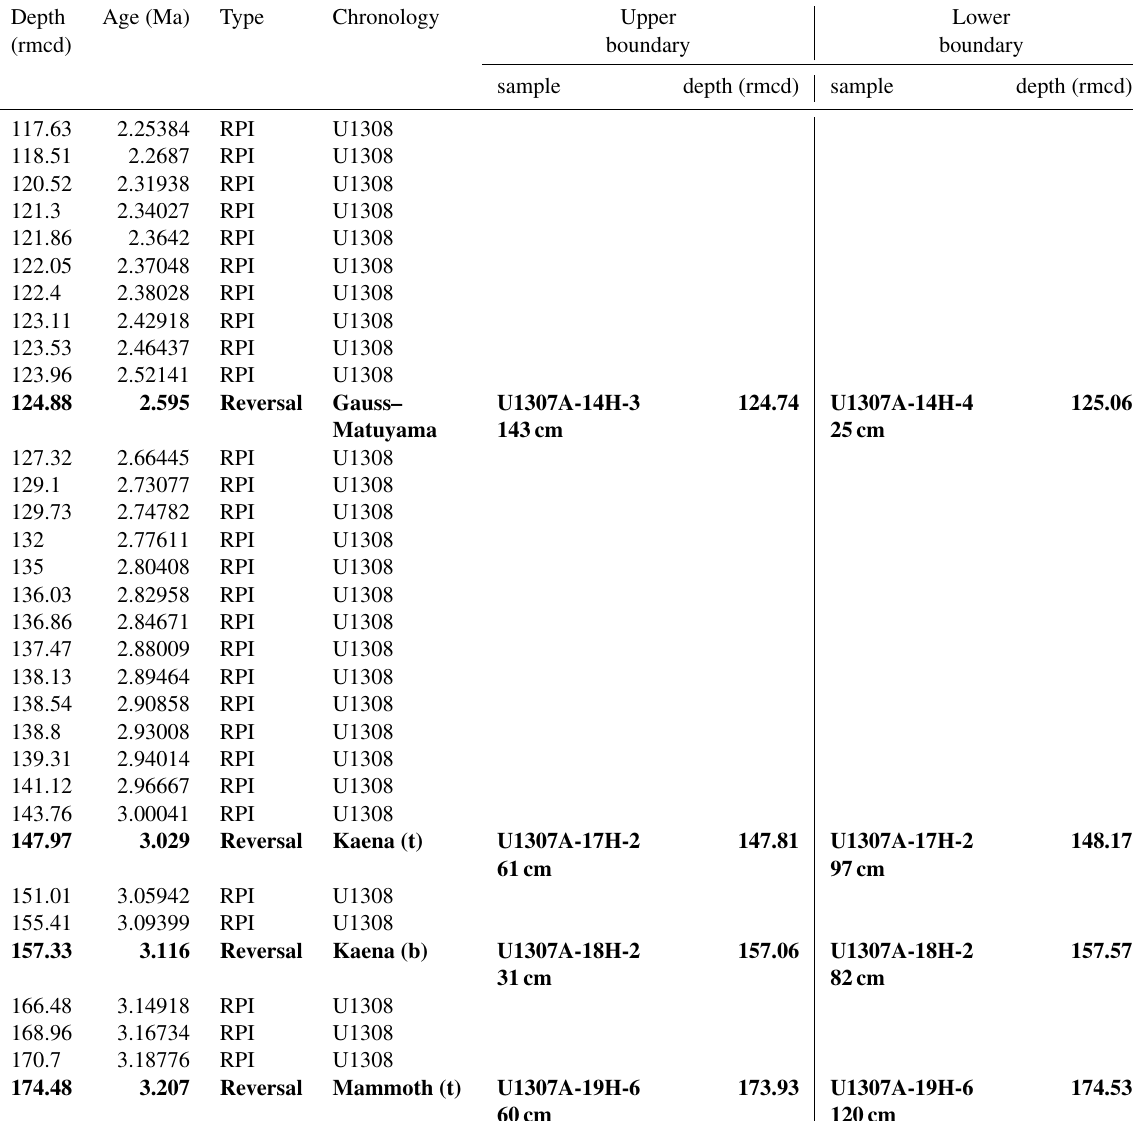
Table 1. Age model tie points used at IODP Site U1307 from Blake-Mizen et al. (2019). Magnetostratigraphic reversals are in bold.